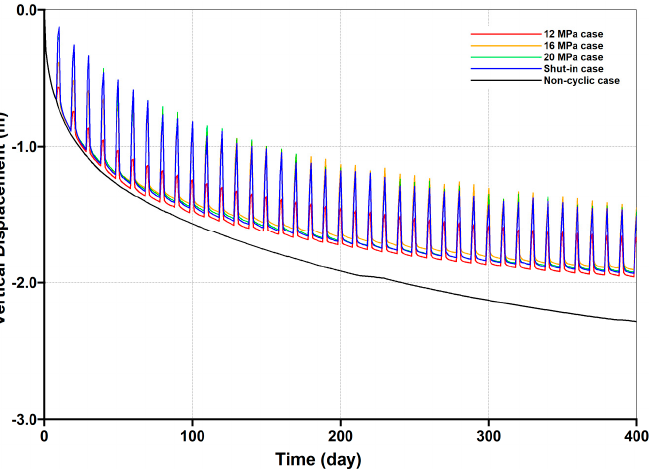
Figure 14. Results of vertical displacement by use of different bottomhole pressure during second- ary depressurization stage.